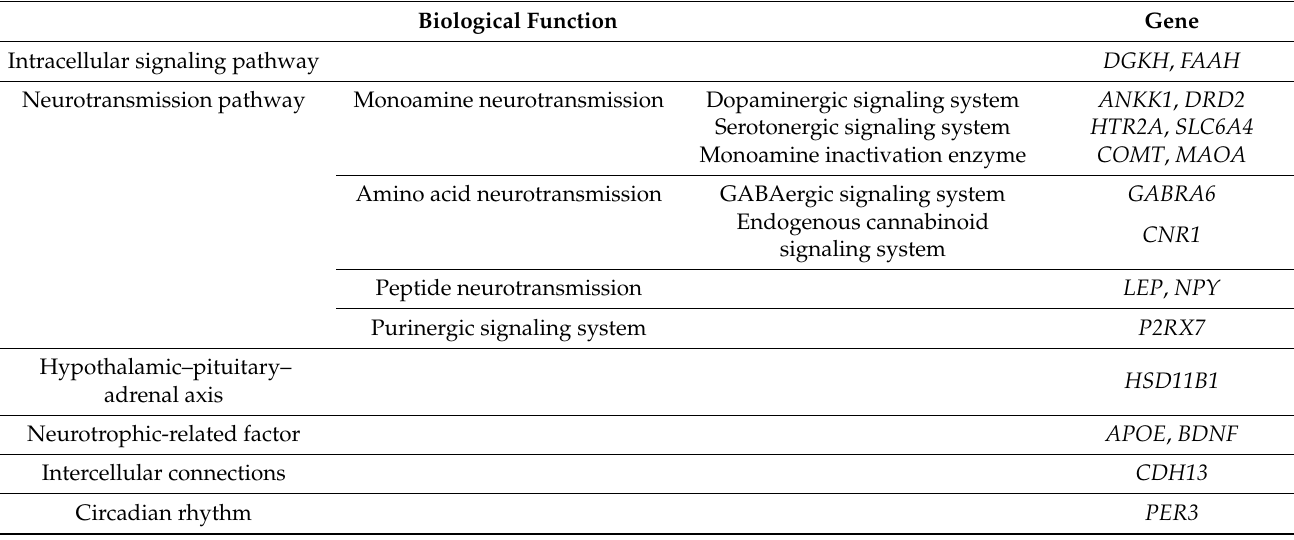
Table 1. Categories of biological function and the classification of equine personality-related gene